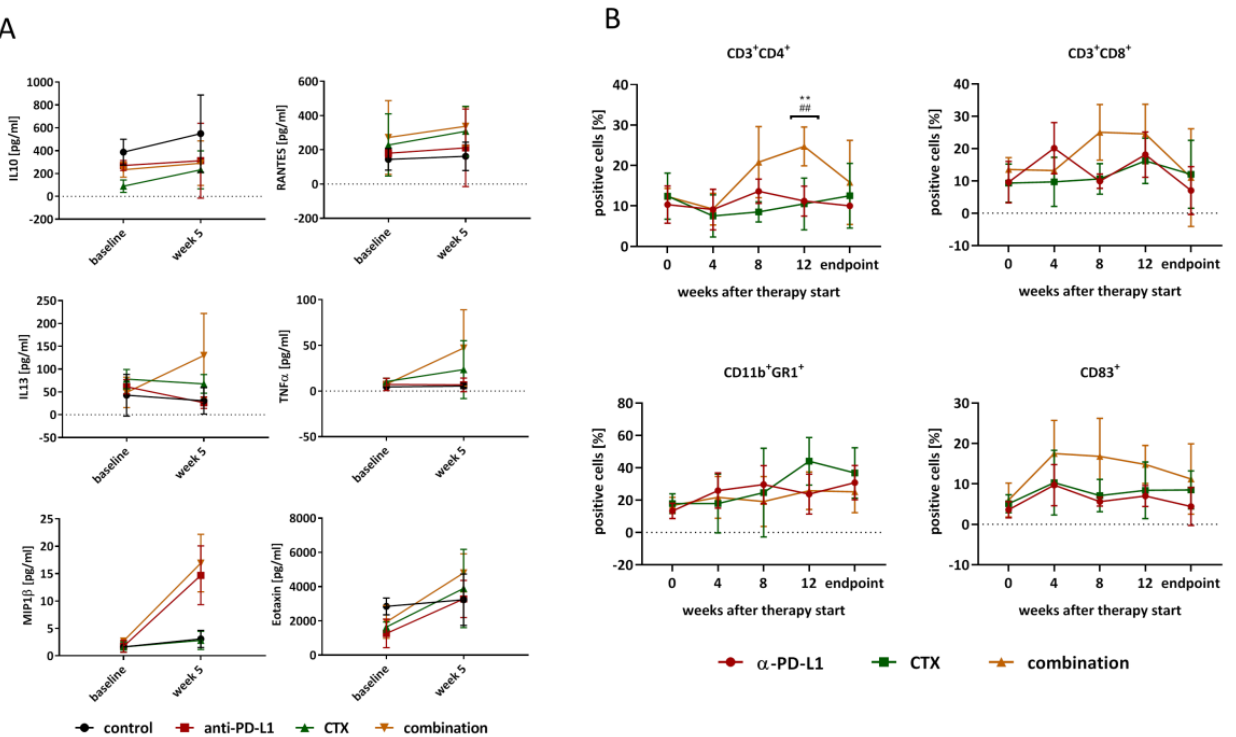
Figure 3. Quantification of plasma cytokine levels and assessment of immunologically relevant markers in the blood. ( A ) Cytokine levels in the plasma were analyzed at beginning of therapy and after 5 weeks. The y-axis shows the mean cytokine levels ± SD. ( B ) Every four weeks, blood was taken from mice under therapy to investigate immunological changes via flow cytometry. Represented are the numbers of positive cells ± SD resulting from 20,000 events, n = 3–5 mice/group. ** p < 0.01 vs. CTX; one-way ANOVA (Bonferroni’s multiple comparison test); ## p < 0.01 vs. α-PD-L1 monotherapy one-way ANOVA (Dunnett’s multiple comparison test).